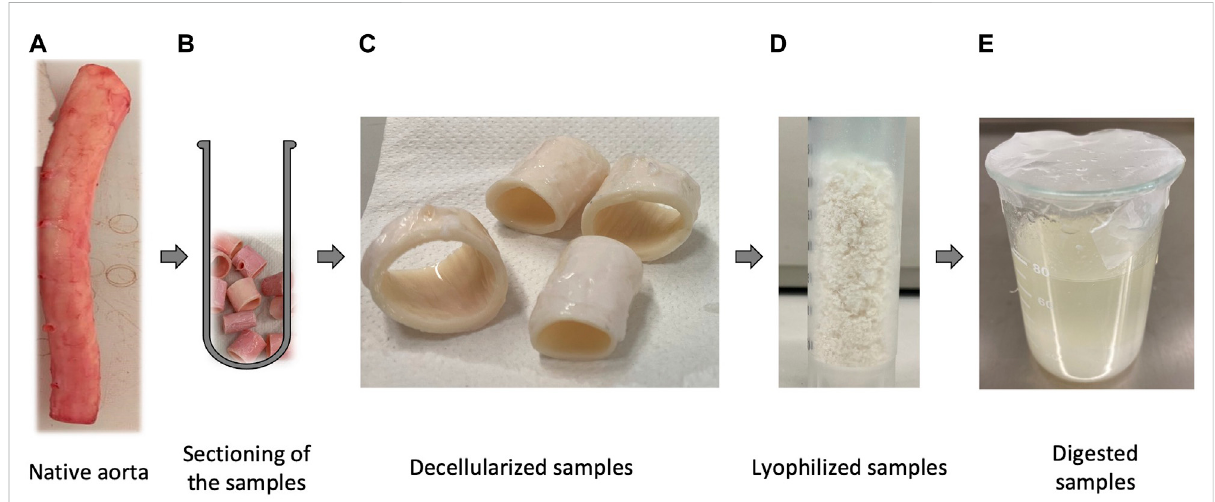
FIGURE 1 Chronologicalpathwayfromthenativetissuetothesolutionofthedigestedporcinenativeaorta.Inparticular: (A) Nativeporcineaortaprovided by a local abattoir; (B) Samples of native aorta cut into segments of approximately 2 cm, ready to be treated with the decellularization process; (C) samples after undergoing the decellularization protocol; (D) powder of the treated samples produced by cryomilling under N 2 ; (E) solution of the decellularized powder performed through enzymatic digestion.